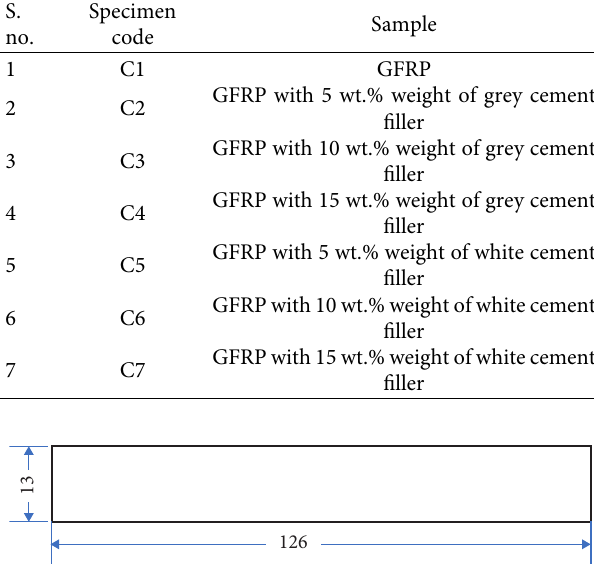
Table 1: Coding of samples.